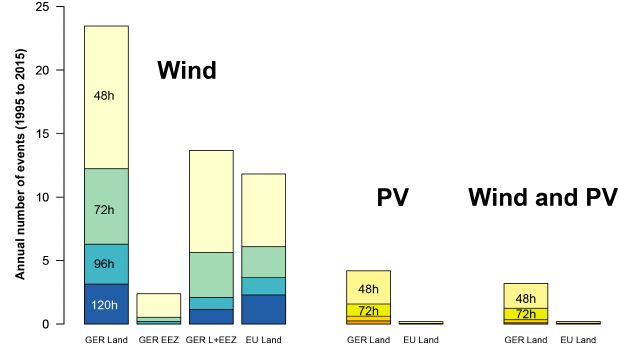
Figure 6. Average annual number of events within a period of 21 years of data when the capacity factor remained below a thresh- old value of 10% for a specific period of time. The frequency is based on the period 1995 to 2015. Several settings are analyzed: Wind, photovoltaics (PV) and a combination of both for the follow- ing regions: German land areas (GER land, the German Exclusive Economic Zone (GER-EEZ), and the European land area (as de- fined in the text). The bars for all event durations refer to the zero point of the y